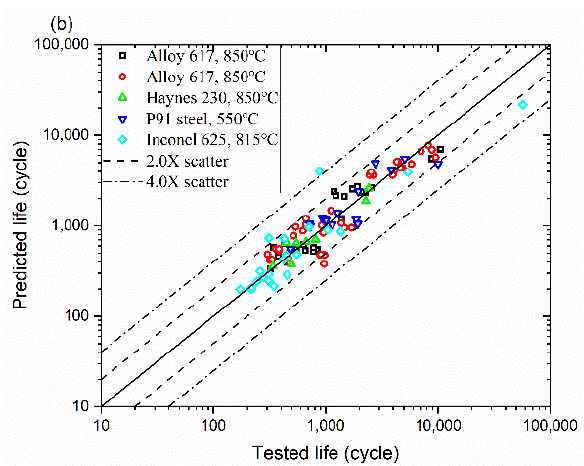
Figure 6. Model predictions by ( a ) present model and ( b ) traditional energy-based model.